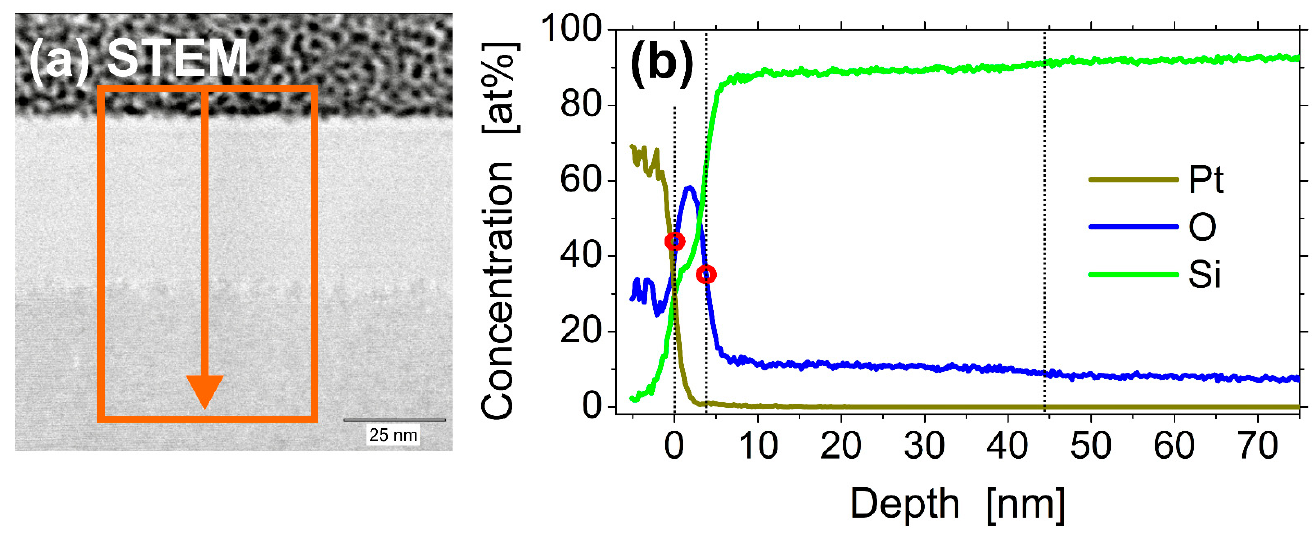
Figure 8. STEM image ( a ) and EDX-based depth profiles ( b ) of the relative atomic concentrations of platinum (Pt, olive green), oxygen (O, blue), silicon (Si, bright green). The data are obtained by binning over the region of interest (ROI) indicated in ( a ) as an orange rectangle. The red circles in ( b ) mark the half-maximum positions of the oxide layer interfaces. The vertical dotted lines indicate the nominal positions of the layer interfaces.